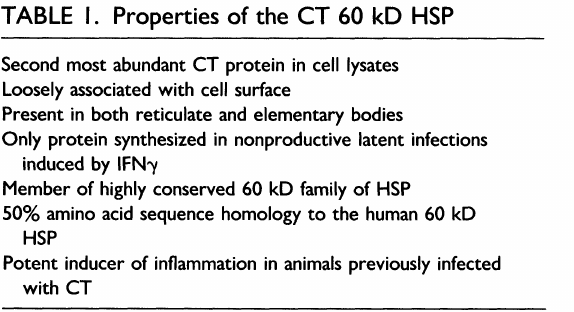
TABLE I. Properties of the CT 60 kD HSP Second most abundant CT protein in cell lysates Loosely associated with cell surface Present in both reticulate and elementary bodies Only protein synthesized in nonproductive latent infections induced by IFN/ Member of highly conserved 60 kD family of HSP 50% amino acid sequence homology to the human 60 kD HSP Potent inducer of inflammation in animals previously infected with